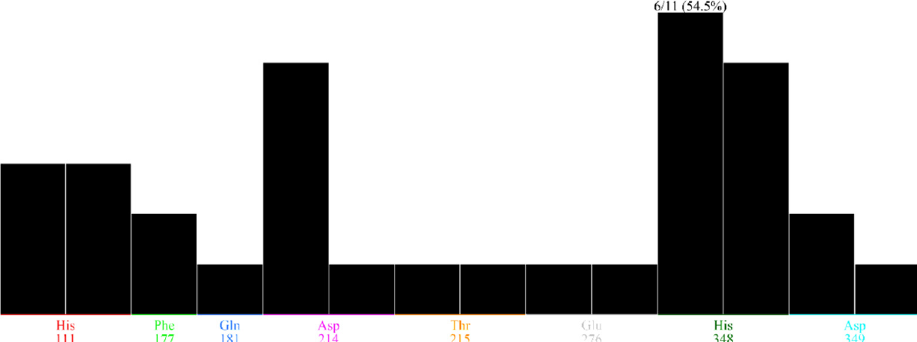
Figure 11. Overall percentage of hydrogen bond interactions of each active pocket residue with the selected inhibitors. His348 interact with 50% (6 compounds out of 10) of the selected compounds, while Asp214 form interactions with the 40% (5 compounds out of 10).